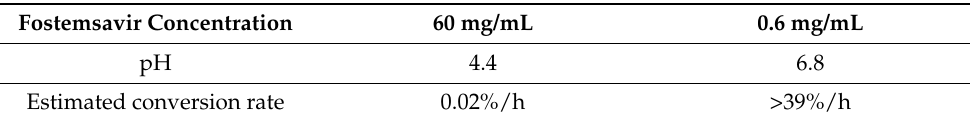
Figure 4. ( a ) Hydrated compact, 1mg/mL, ALP in Tris buffer at 3 h ( b ) Hydrated control, no ALP in Tris buffer at 3 h. Table 1. Effect of fostemsavir concentration on solution pH and conversion rate of prodrug to parent in pH 7.0 Tris